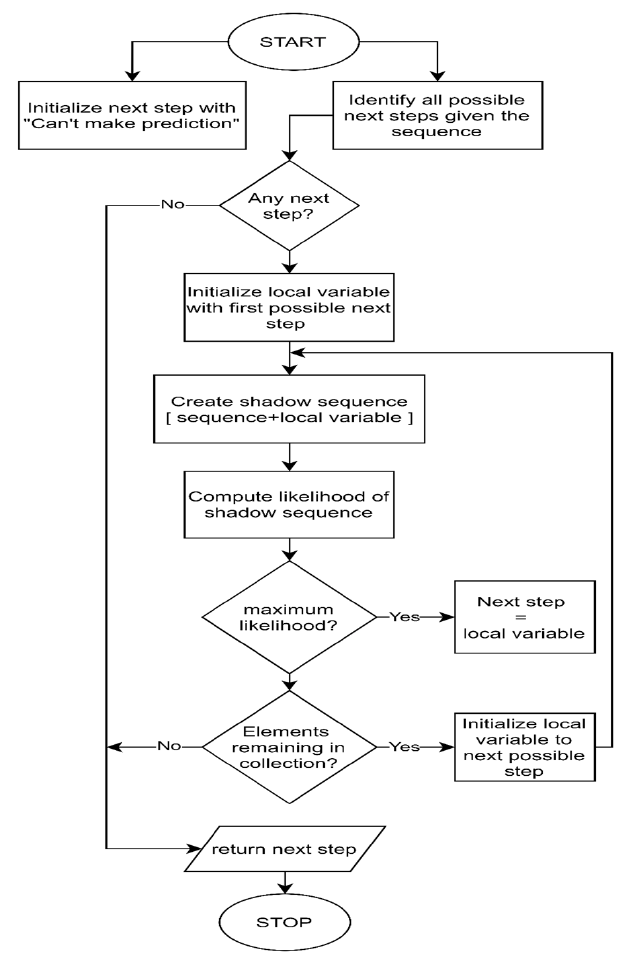
Figure 5. Prediction flowchart for HMM.